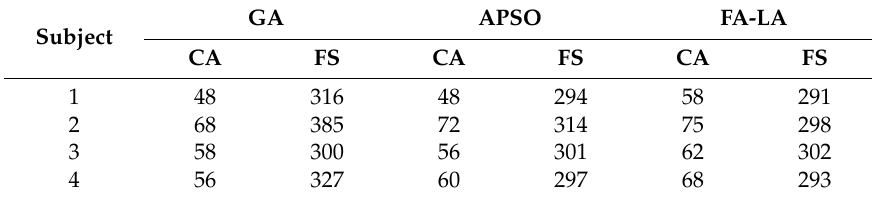
Table 7. Comparison of classification accuracy (CA, %) and the number of features selected (FS) between the three algorithms: GA, APSO, and FA-LA, for real-time MI EEG signals.